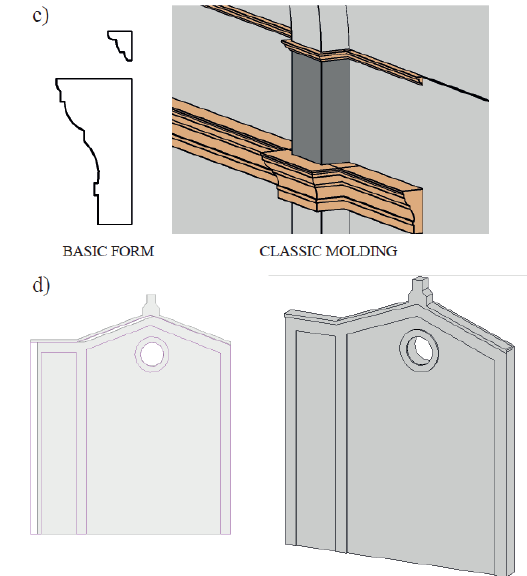
Fig. 7. Parametric objects library; c) set of moldings (listel, strips, half bocel and caveto) that are basic elements of classical architecture; d) Striped pediment where the upper part is interrupted by an ornamental motif